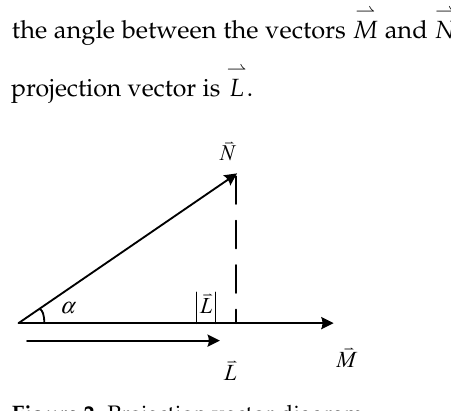
Figure 2. Projection vector diagram.